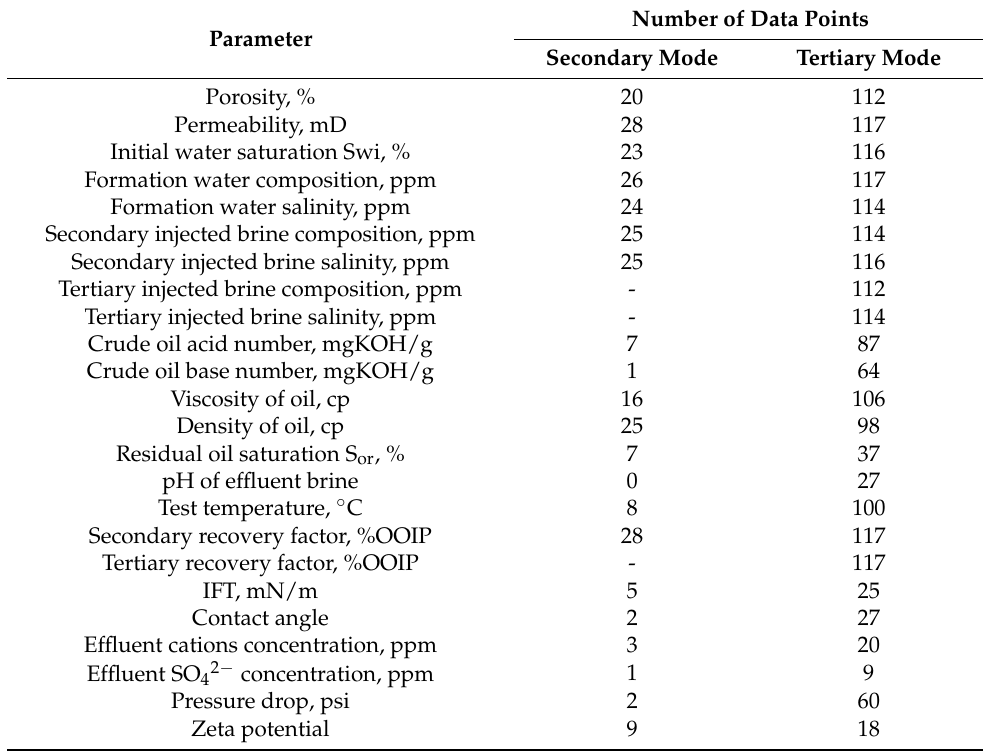
Table 1. Number of data points extracted from the literature for different rock/fluid parameters.